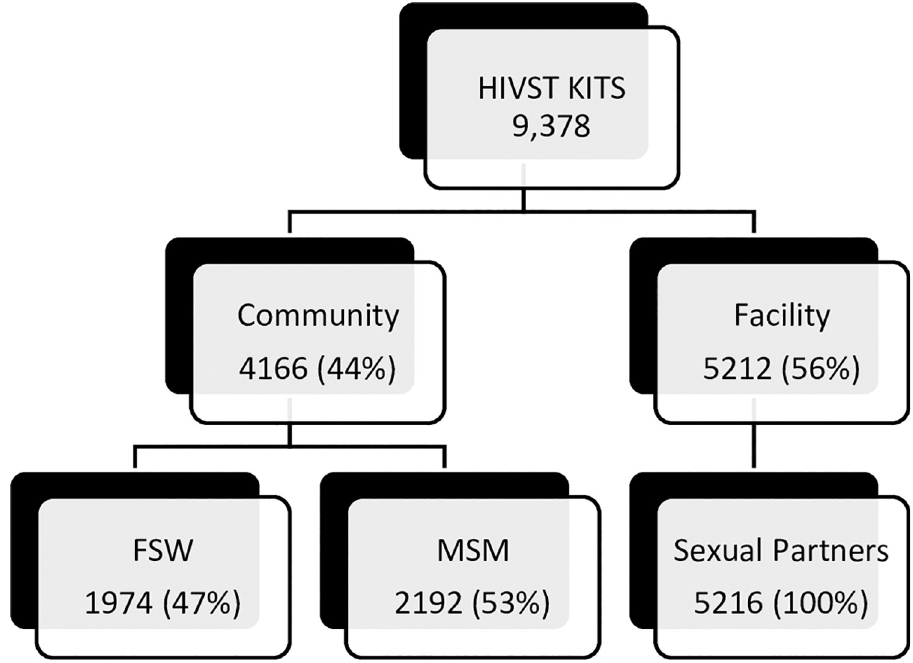
Fig 1. Flow chart showing the client